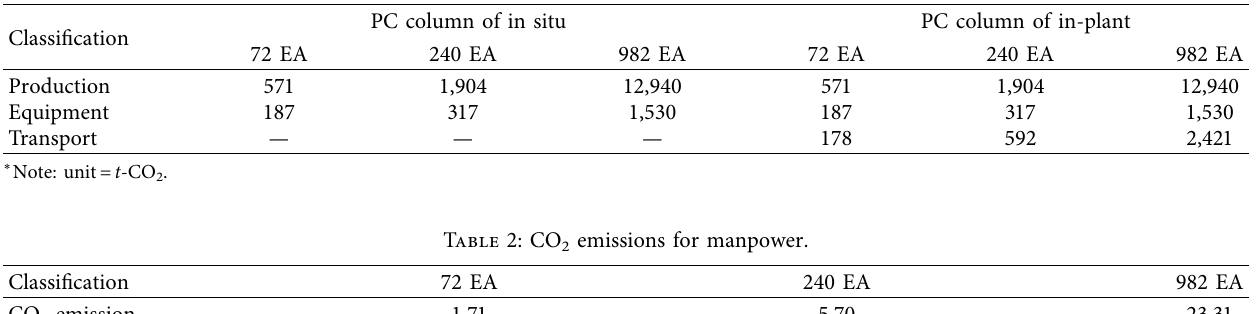
Table 1: CO 2 emissions for production, transportation, and equipment [8].